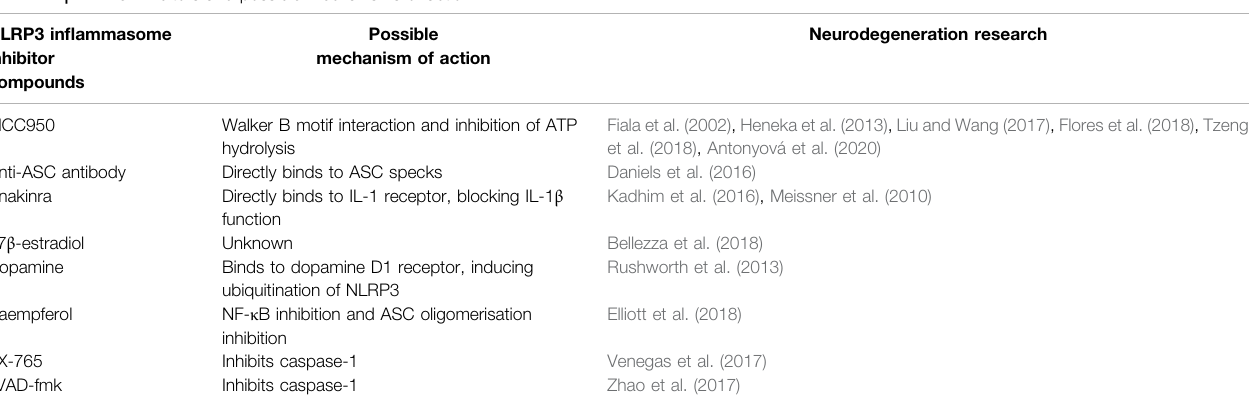
TABLE 2 | NLRP3 inhibitors and possible mechanisms of